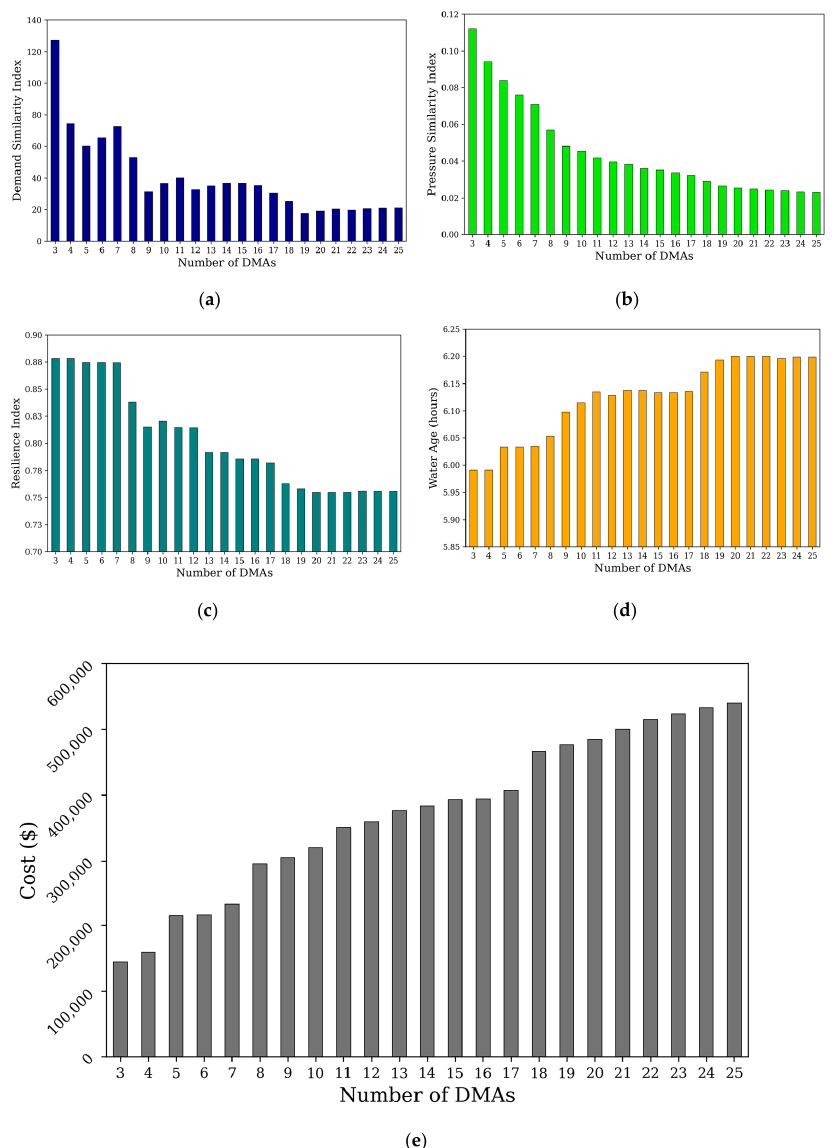
Figure 10. Performance of different DMA layouts on various criteria: ( a ) DSI; ( b ) PSI; ( c ) RI; ( d ) WA; ( e ) investment costs (Cost).